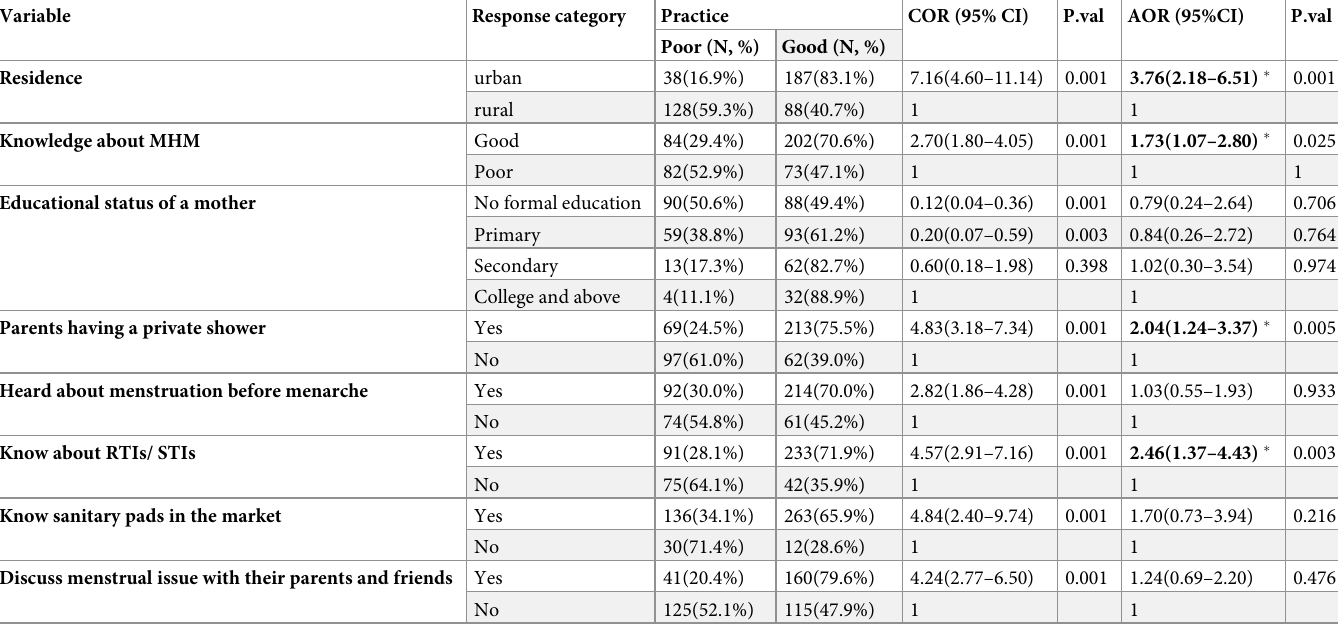
Table 5. Factors independently associated with menstrual hygiene practice of Mekdela secondary school girl students, Amhara region, Northeast Ethiopia